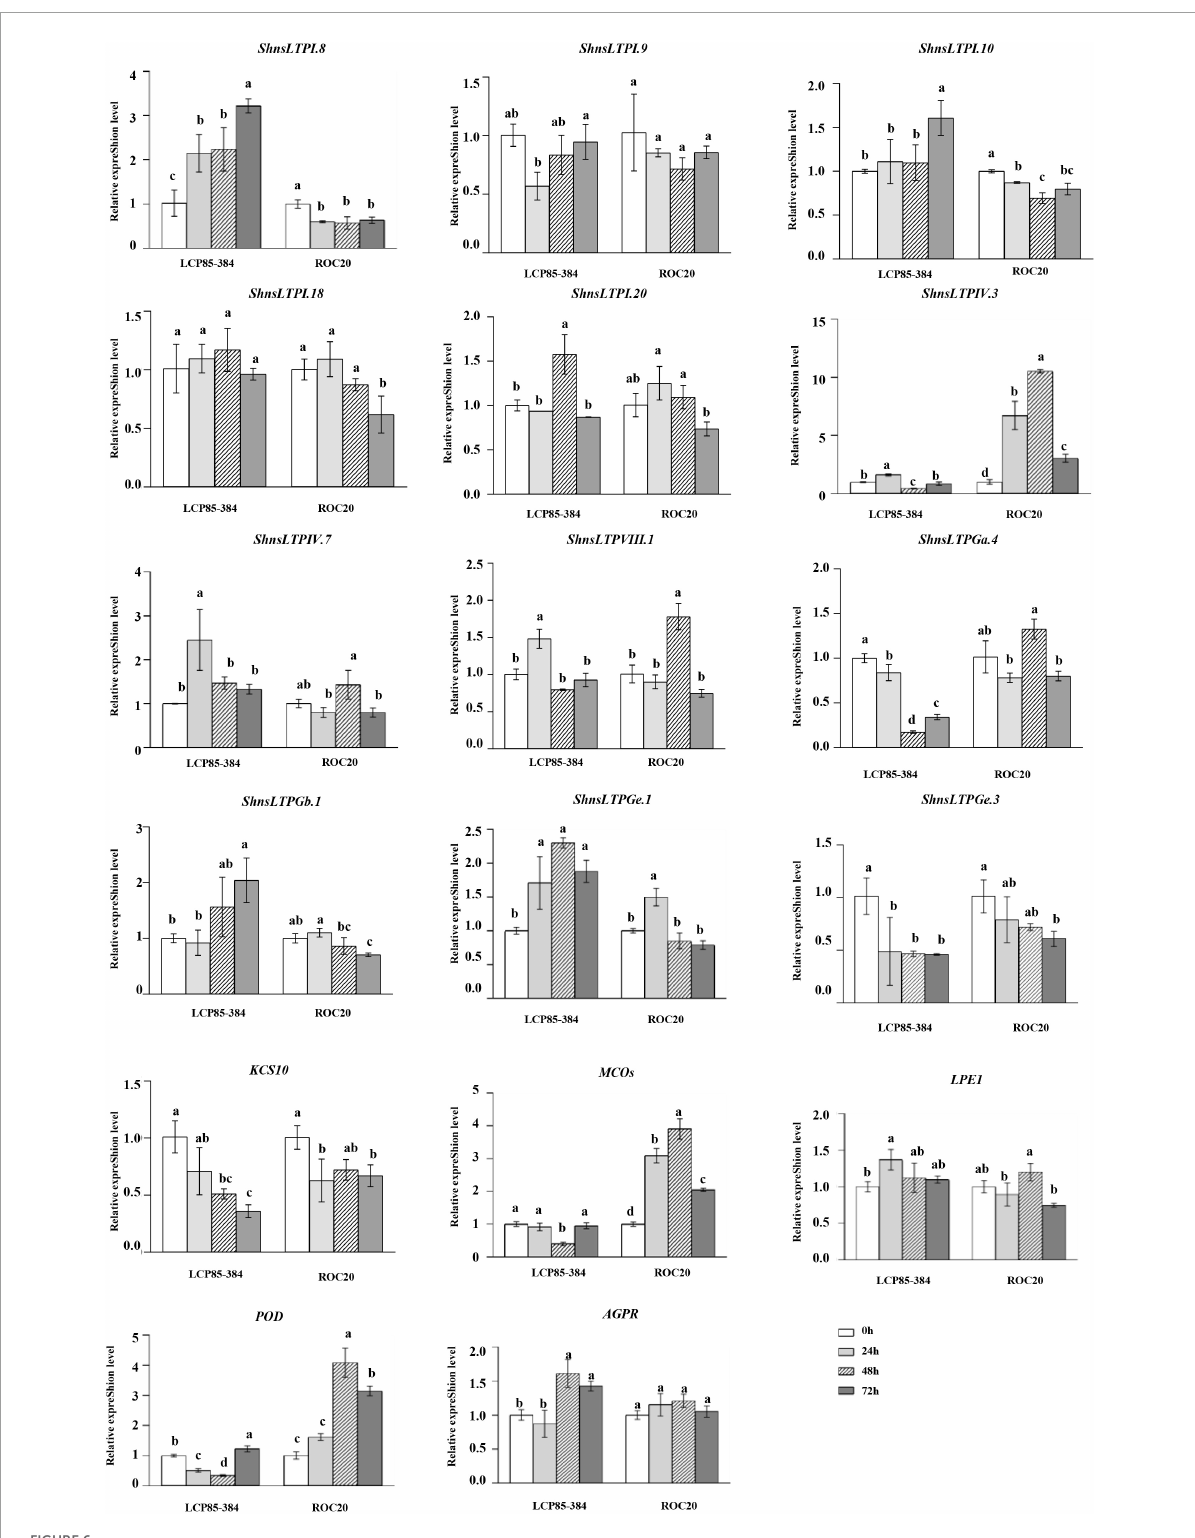
FIGURE6 Transcript expression levels of 12 ShnsLTPs and 5 interacting protein genes in LCP85-384 (resistant to leaf scald) and ROC20 (susceptible to leaf scald) sugarcane cultivars after X. albilineans infection. The bars indicate mean ± SD ( n = 9). The same letters indicate no significant difference ( p >